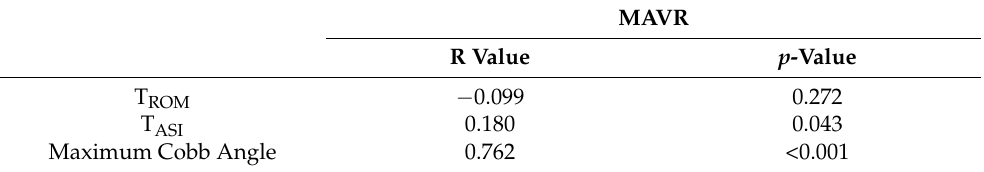
Table 7. Correlation of T ROM and T ASI in AIS patients with patients’ maximum axial vertebral rotation. MAVR R Value p -Value T